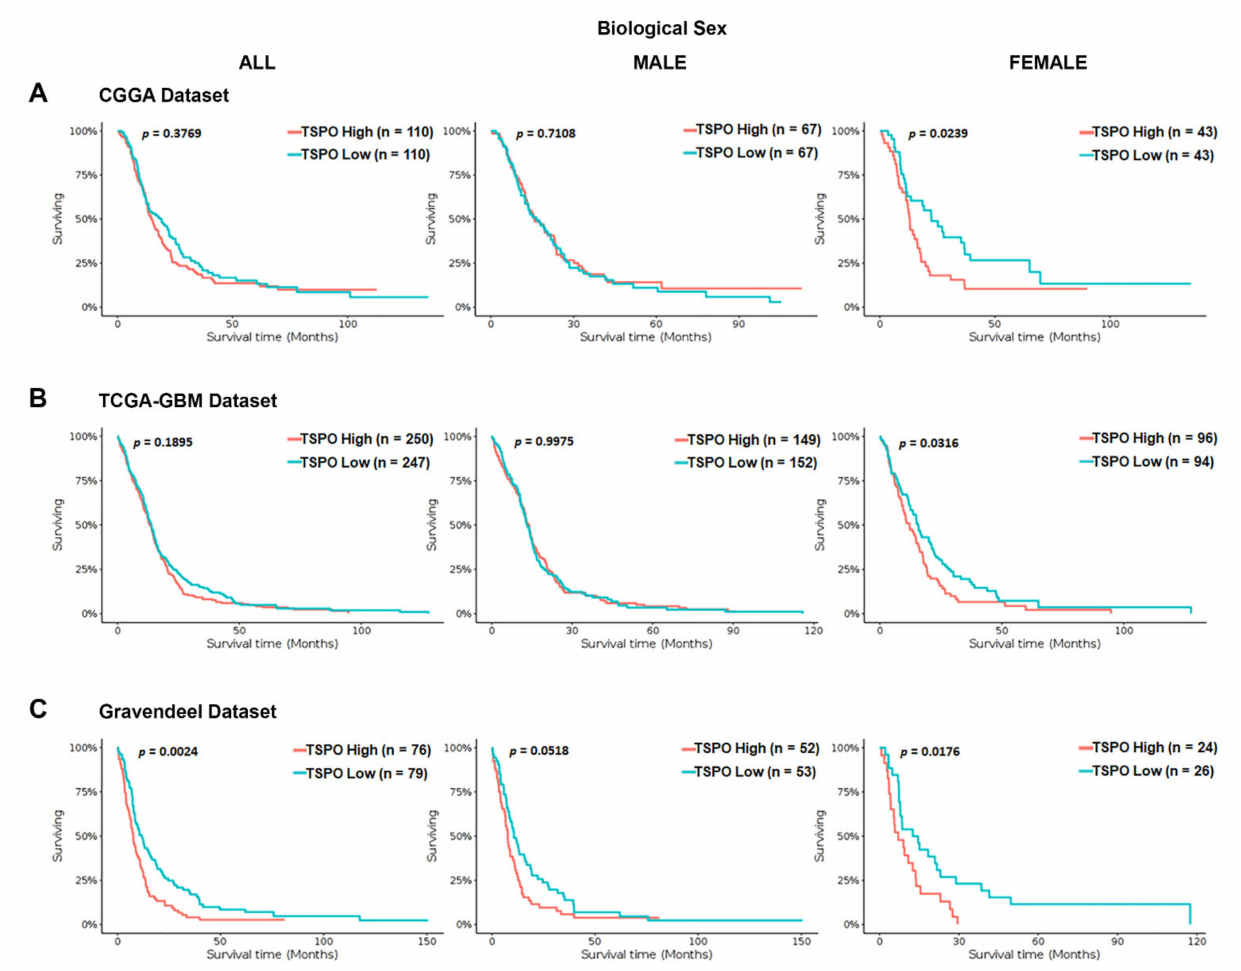
Figure 2. Kaplan–Meier survival curves of TSPO mRNA expression in GBM patients stratified by biological sex using the CGGA, TCGA-GBM, and Gravendeel datasets. Overall survival of GBM patients with a high or low expression of TSPO , using the median as the cutoff value, was analyzed using the ( A ) CGGA database, ( B ) the TCGA-GBM database (Affymetrix HG-U133A platform), and ( C ) Gravendeel database, available at GlioVis data portal. Survival curves analysis were stratified by biological sex, including the entire population ( left panel ), male population ( middle panel ), and the female population ( right panel ) for the three independent databases. Genotype patient numbers and p -values are indicated in each graph, and the median and statistical data are in Table